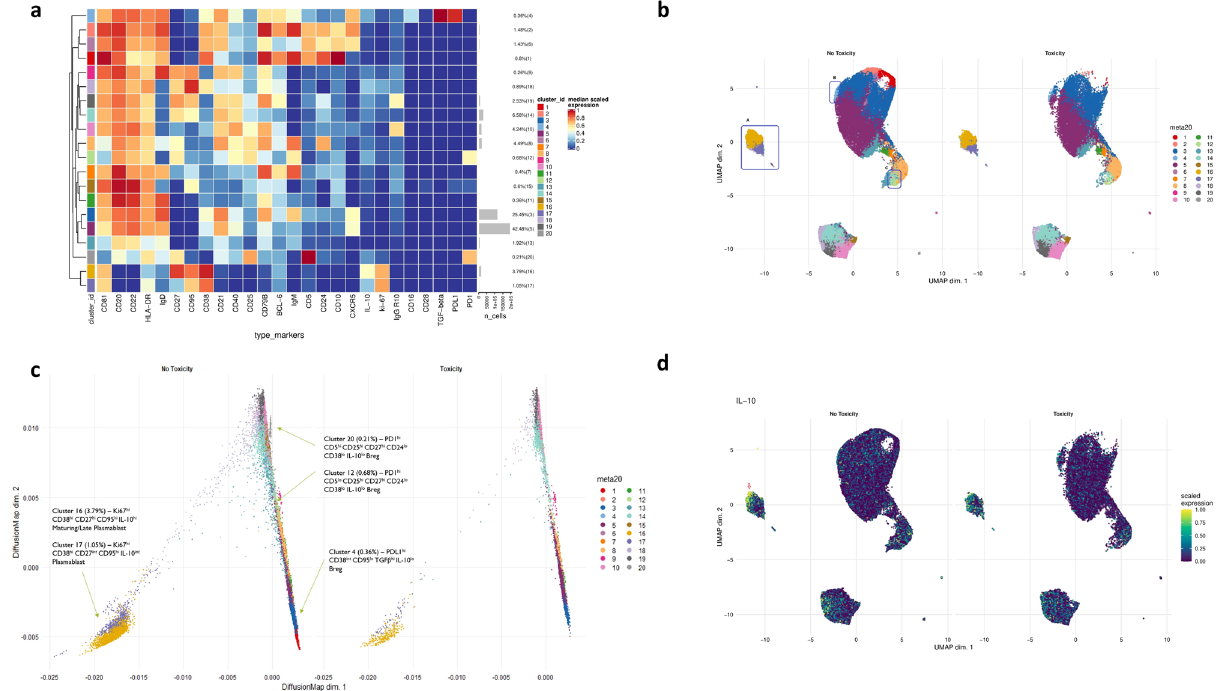
Fig. 6 De fi ciencies of speci fi c B-cell populations in toxicity patients ( n = 8) identi fi ed in an independent validation NSCLC cohort. a Heatmap showing normalised expression of the base B-cell panel markers for the 20 B-cell clusters identi fi ed with FlowSOM. The cluster IDs and relative frequencies are displayed as a bar graph on the right-hand side, along with the median scaled expression. b UMAP plots strati fi ed according to condition, “ no toxicity ” , “ toxicity ” and “ healthy controls ” . Clusters highlighted by blue boxes correspond to clusters identi fi ed from ( A ). These clusters are attenuated in the “ toxicity ” cohort in this unsupervised analysis. The box labelled “ A ” is encircling clusters 16 (mustard) and 17 (lilac). The box labelled “ B ” is encircling cluster 4 (light blue). The box labelled “ C ” is encircling cluster 12 (light green). All samples are randomly downsampled to account for equally representative populations across samples. c Diffusion map strati fi ed according to condition, “ no toxicity ” , “ toxicity ” and “ healthy controls ” . Clusters labelled 4, 12, 16, 17 and 20 are attenuated in the “ toxicity ” cohort in this unsupervised analysis. Cluster 4 is shown by the thin “ light blue ” line of cells to the right of the darker blue cells in cluster 3. All samples are randomly downsampled to account for equally representative populations across samples. d Bulk expression UMAP strati fi ed according to IL-10 expression, which demonstrates less intense IL-10 expression in the toxicity cohort compared to the non-toxicity patients. Expression is largely con fi ned to the Breg clusters demarcated by the red arrows. Matched IL-10 expression in the corresponding clusters in the toxicity patients is